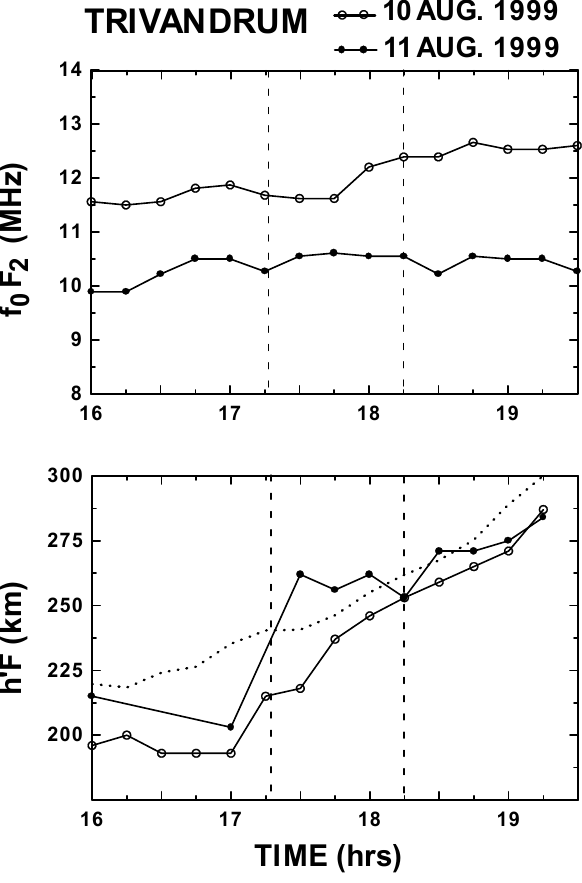
Fig. 5. A comparison of the variations in fo F2 (top panel) and h 0 F (bottom panel) observed at Trivandrum on 10 and 11 August during 16:00–19:30IST. The dotted curve represents the quiet day average values of h 0 F during this period in the month of August